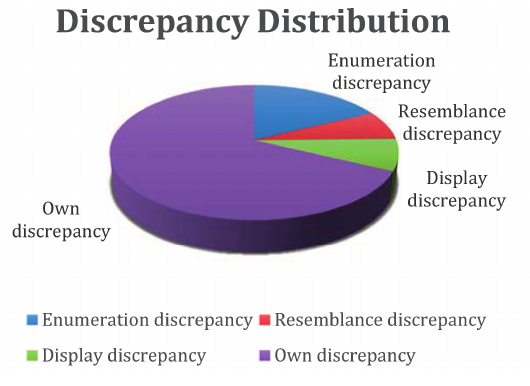
Figure 4. Discrepancy